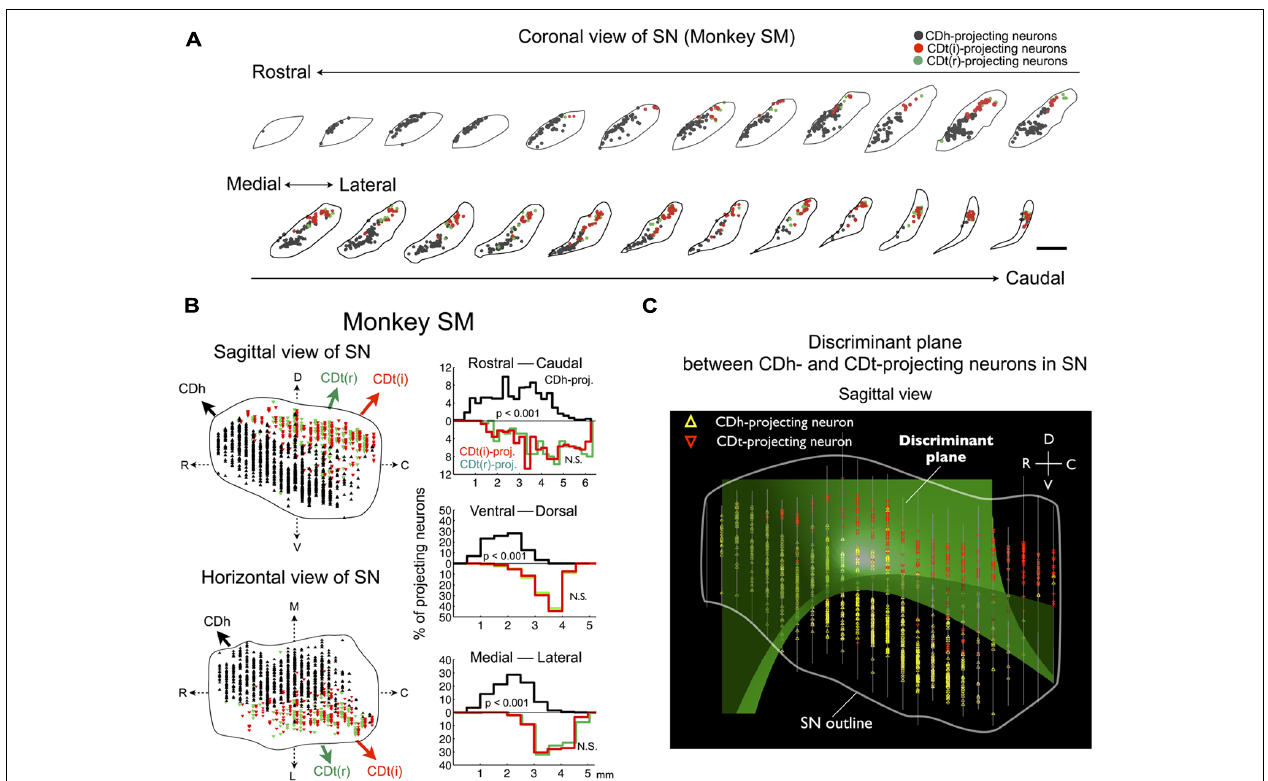
respectively. Their distributions are projected to each of 3D axes (right). The P values were calculated by two-tailed t -test. (C) Discriminant analysis. CDh- and CDt-projecting neurons were best separated by a single quadratic plane (green). The neurons’ locations are projected to a parasagittal plane. White line indicates the border of SN. Between-slice interval: 250 μ m